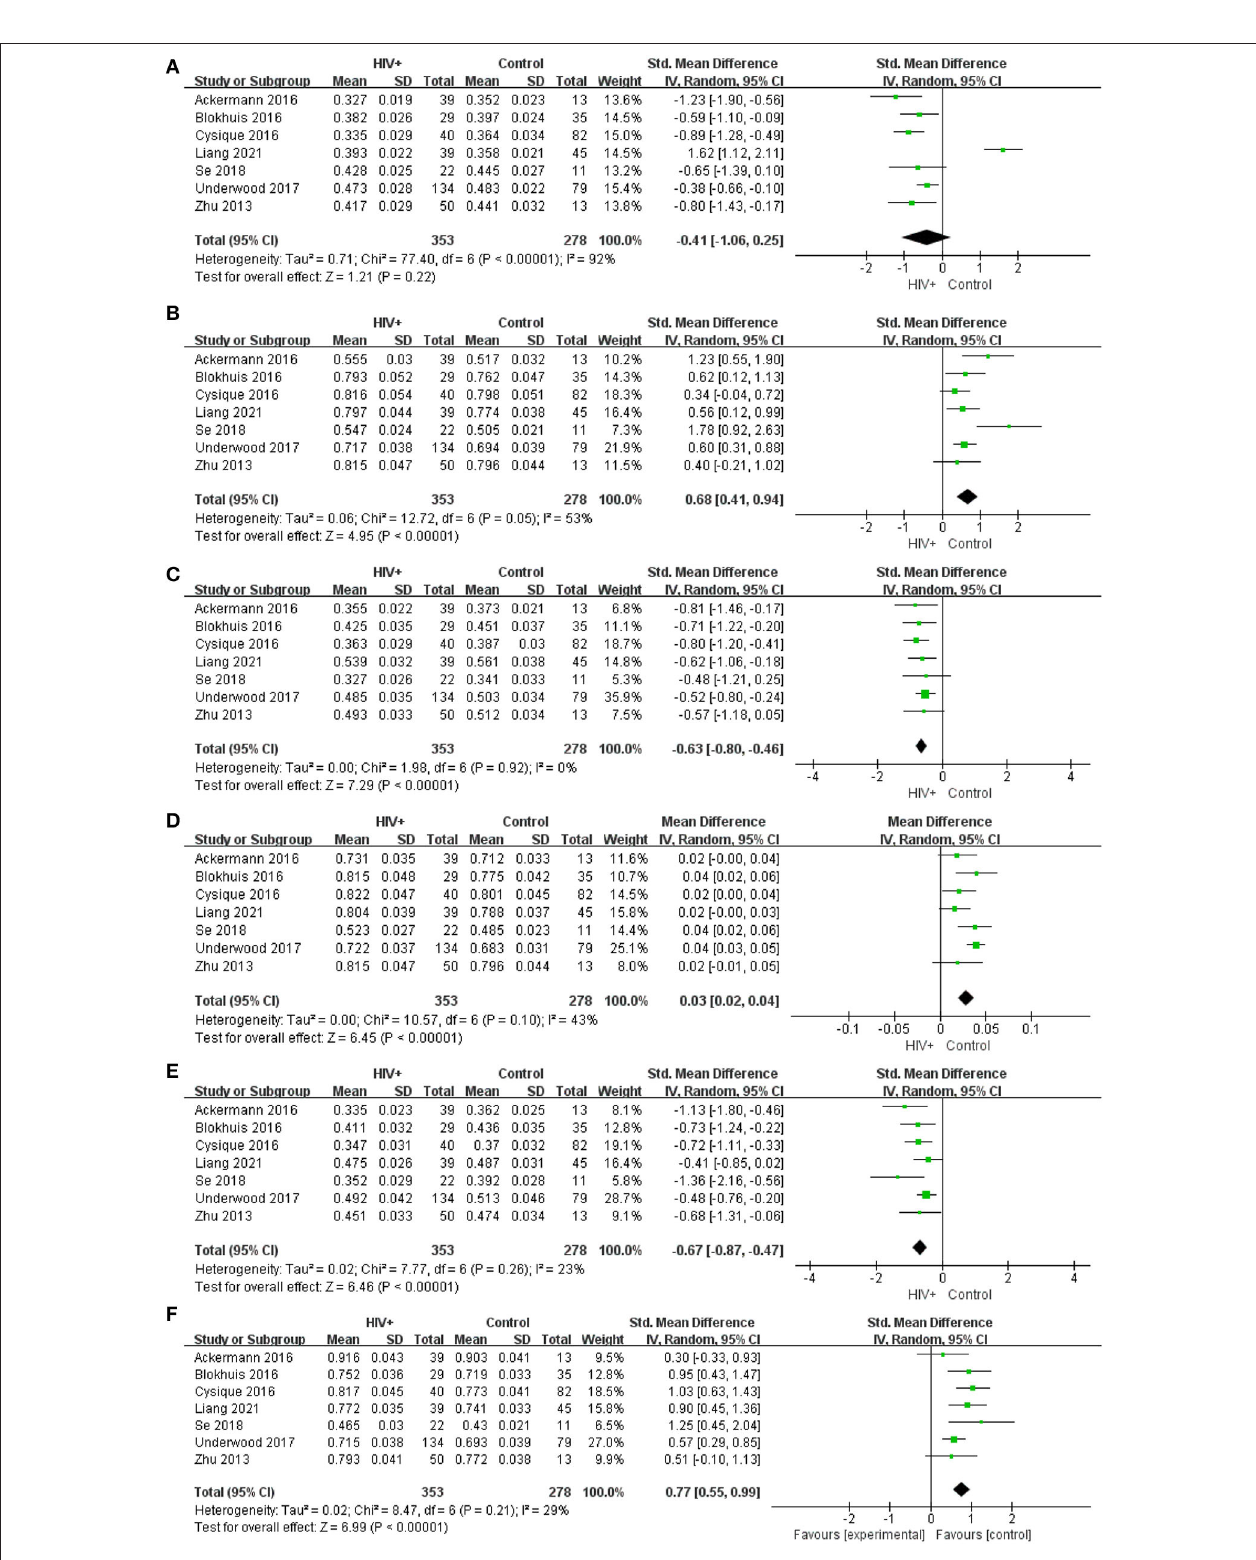
FIGURE 5 | Meta-analysis results of FA and MD between the HIV positive group and the control group. (A–F) Represent FA in CST, MD in CST (*10 − 3 ), FA in SLF, MD in SLF (*10 − 3 ), FA in IFOF, MD in IFOF (*10 − 3 ).